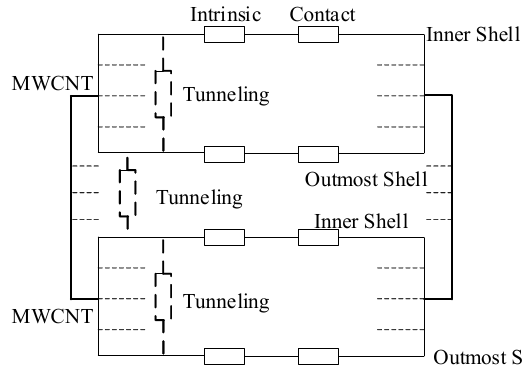
Figure 4. Resistance circuit model for MWCNT bundle.